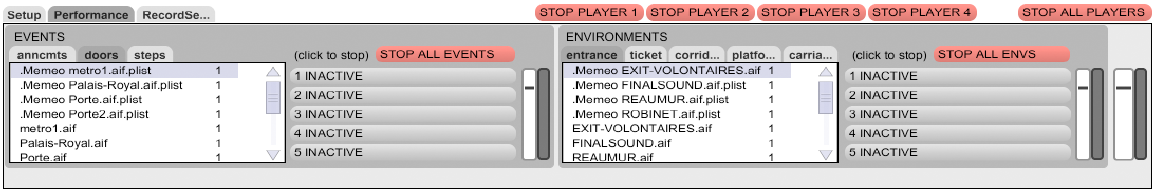
2 | Fig. 2. – Detail of features of the “Performance” tab.